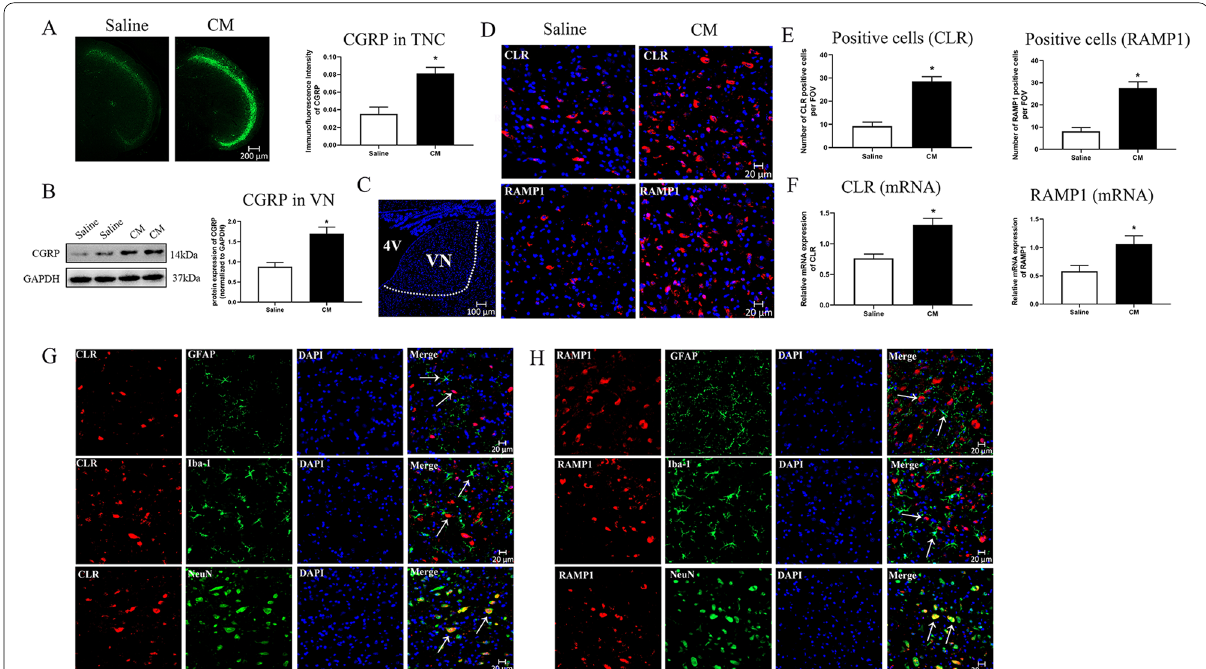
Fig. 2 Increased expression levels of calcitonin gene-related peptide (CGRP) and its receptor components in the vestibular nucleus (VN) after CM. A Representative micrographs and quantitative analysis of CGRP positive (green) fibers in the trigeminal nucleus caudalis (TNC). n group. B Representative western blots bands and densitometric quantification of CGRP in VN. n shows the VN region depicted with a white dotted line. Representative micrographs ( D ) and quantitative analysis ( E ) of calcitonin receptor-like receptor (CLR) and receptor activity modifying protein 1 (RAMP1) in VN. n group. G H Representative microphotographs of co-immunofluorescence staining of CLR (red) and RAMP1 (red) with astrocytes (GFAP, green), microglia (Iba-1, green), and neurons (NeuN, green) in VN after CM. The nuclei were stained with DAPI (blue). n FOV 1.02 10 6 µm 3 . One-way ANOVA, Dunnett; * p < 0.05 compared with saline group. 4 V: the fourth = ×